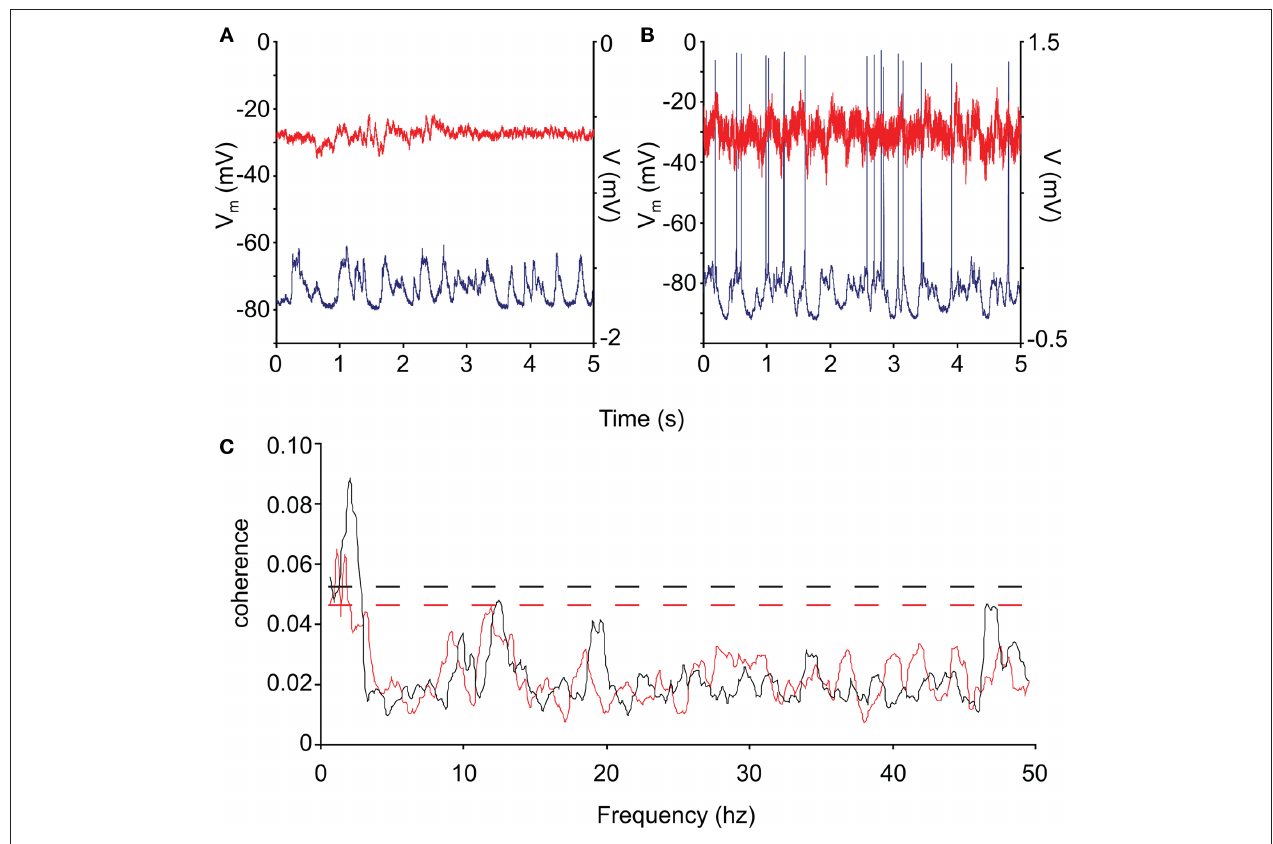
potential with the global activity represented by the ECoG is significantly less than that of the controls in the low-frequency range ( < 5 Hz), which represents the state transition activity. The dashed lines represent the 95% confidence intervals of the